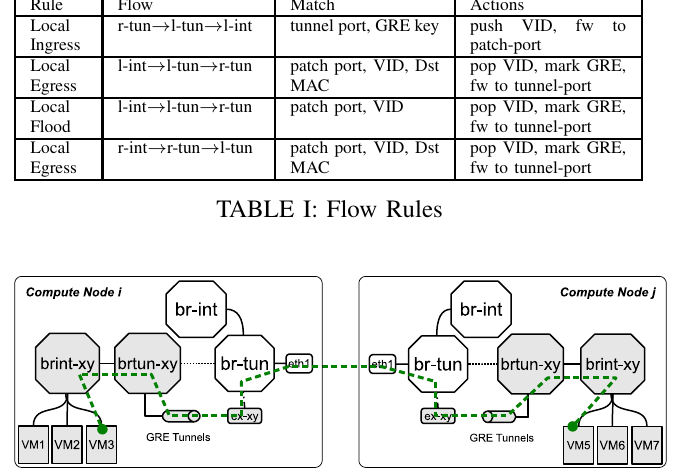
Fig. 3: Flows of packets between two VMs of a tenant across two compute